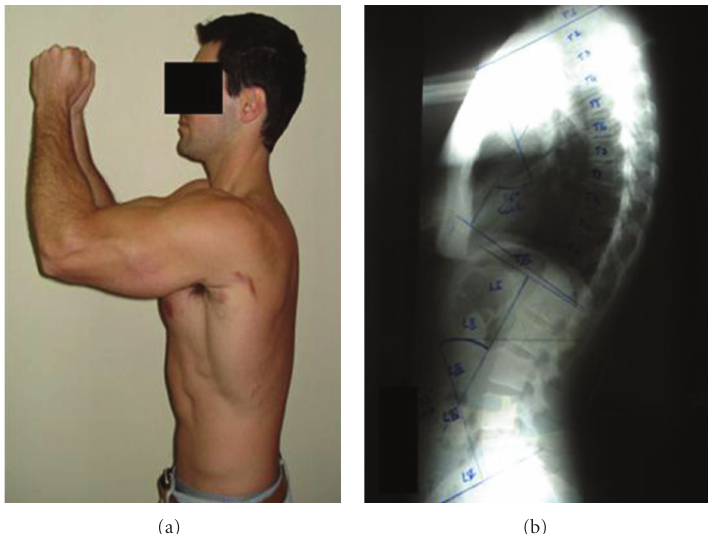
Figure 1: (a) Position of the subjects during both evaluation procedures; (b) X-ray image of the spine.